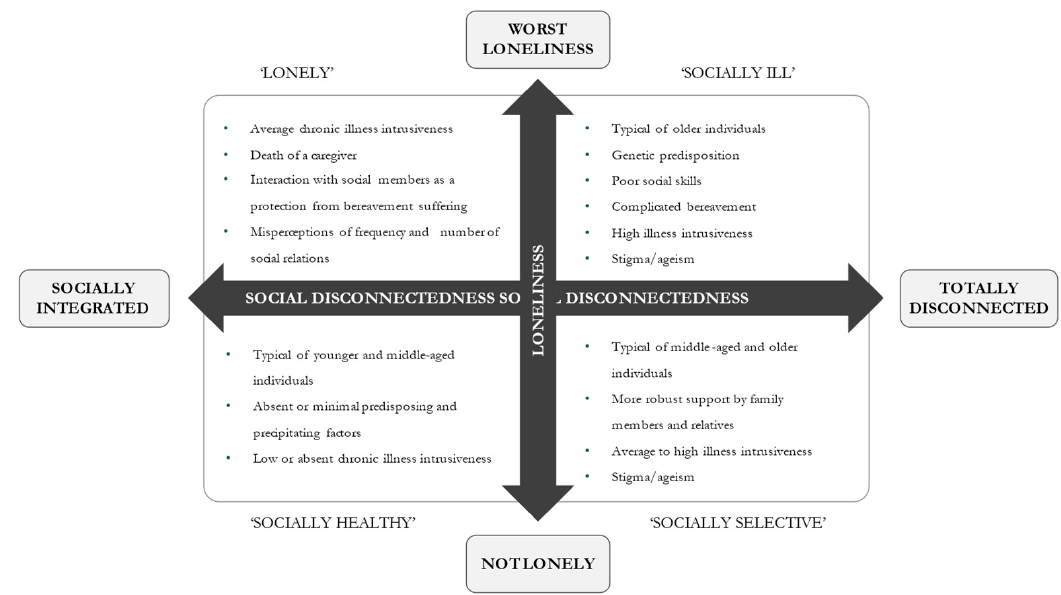
Figure 2. Hypothesized patterns of social isolation and their characteristics in chronic